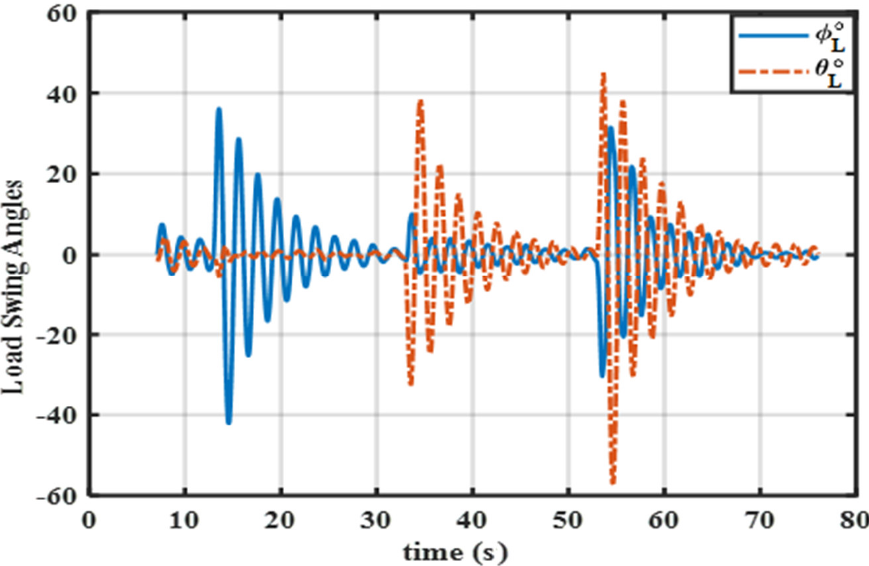
Figure 20. Time history of the load swing angle during travel maneuver without the ASC .